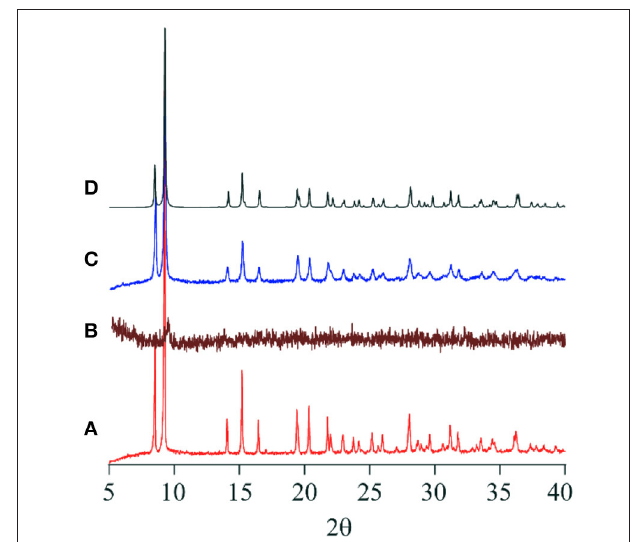
this section, the thermochromic behavior of 1-Br is described.